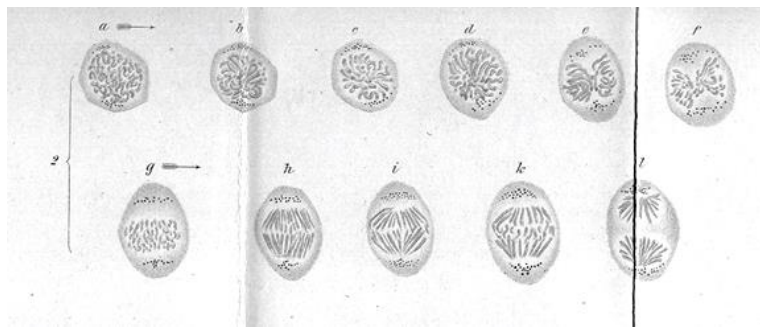
Figure 5. Drawings of chromosome segregation in living epidermal cells of a salamander larva.